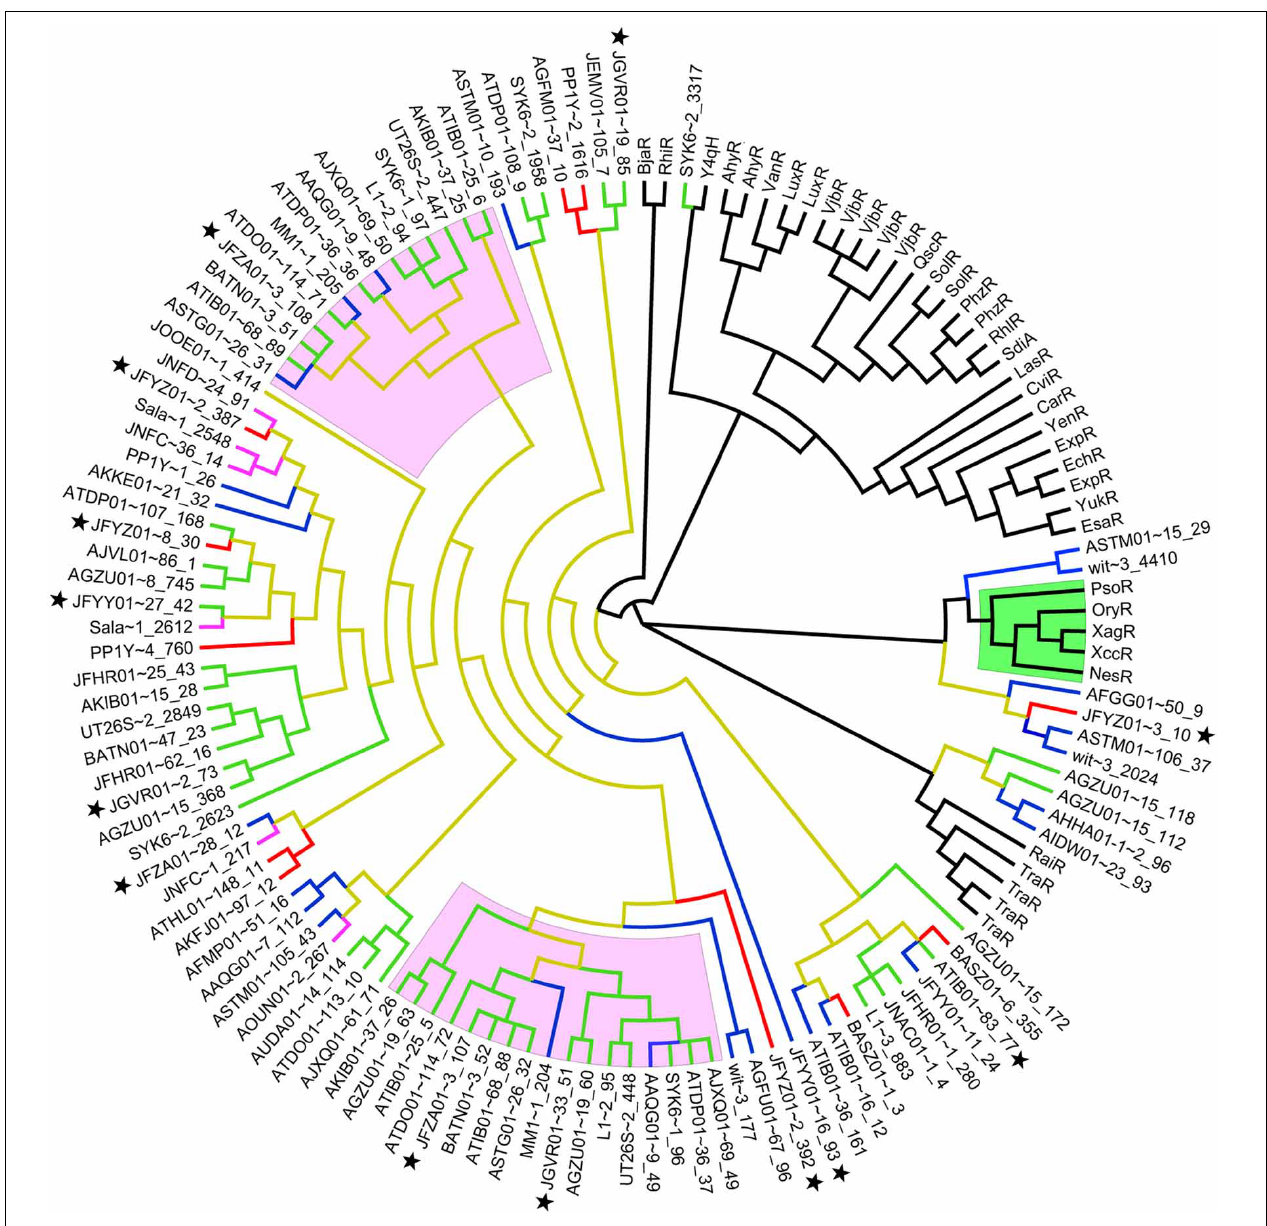
FIGURE 3 | Unrooted phylogenetic tree of functionally validated LuxR homologs, Plant associated bacteria (PAB) LuxR Solos (Gonzalez and Venturi, 2013) and Identified sphingomonad LuxR Homologs. Clades highlighted in green and pink represent PAB LuxR solos and sphingomonad double LuxR, LuxI, respectively. Branches colored in brown, blue, red, green,